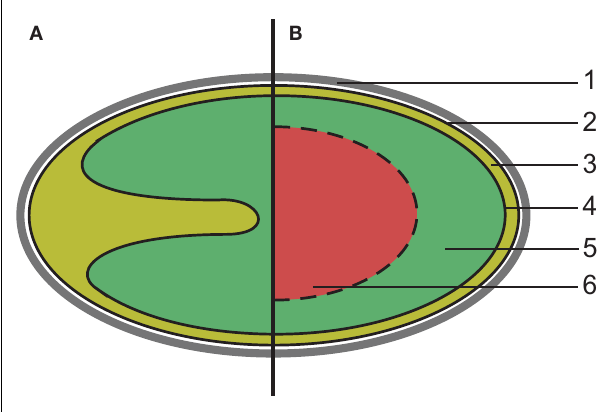
FIGURE 1 | Schematic overview of the canonical Planctomycete cell plan. (1) proteinaceous cell wall, (2) cytoplasmic membrane, (3) paryphoplasm, (4) intracytoplasmic membrane, (5) riboplasm, (6) additional compartment (anammoxosome or nuclear body). (A) All Planctomycetes share at least two compartments enclosed by membranes (solid lines).The intracytoplasmic membrane is strongly curved in some species, such as Isosphaera pallida . (B) In some members of the phylum, such as anammox bacteria and Gemmata sp. a third compartment is present, bounded by a single or double membrane (dashed